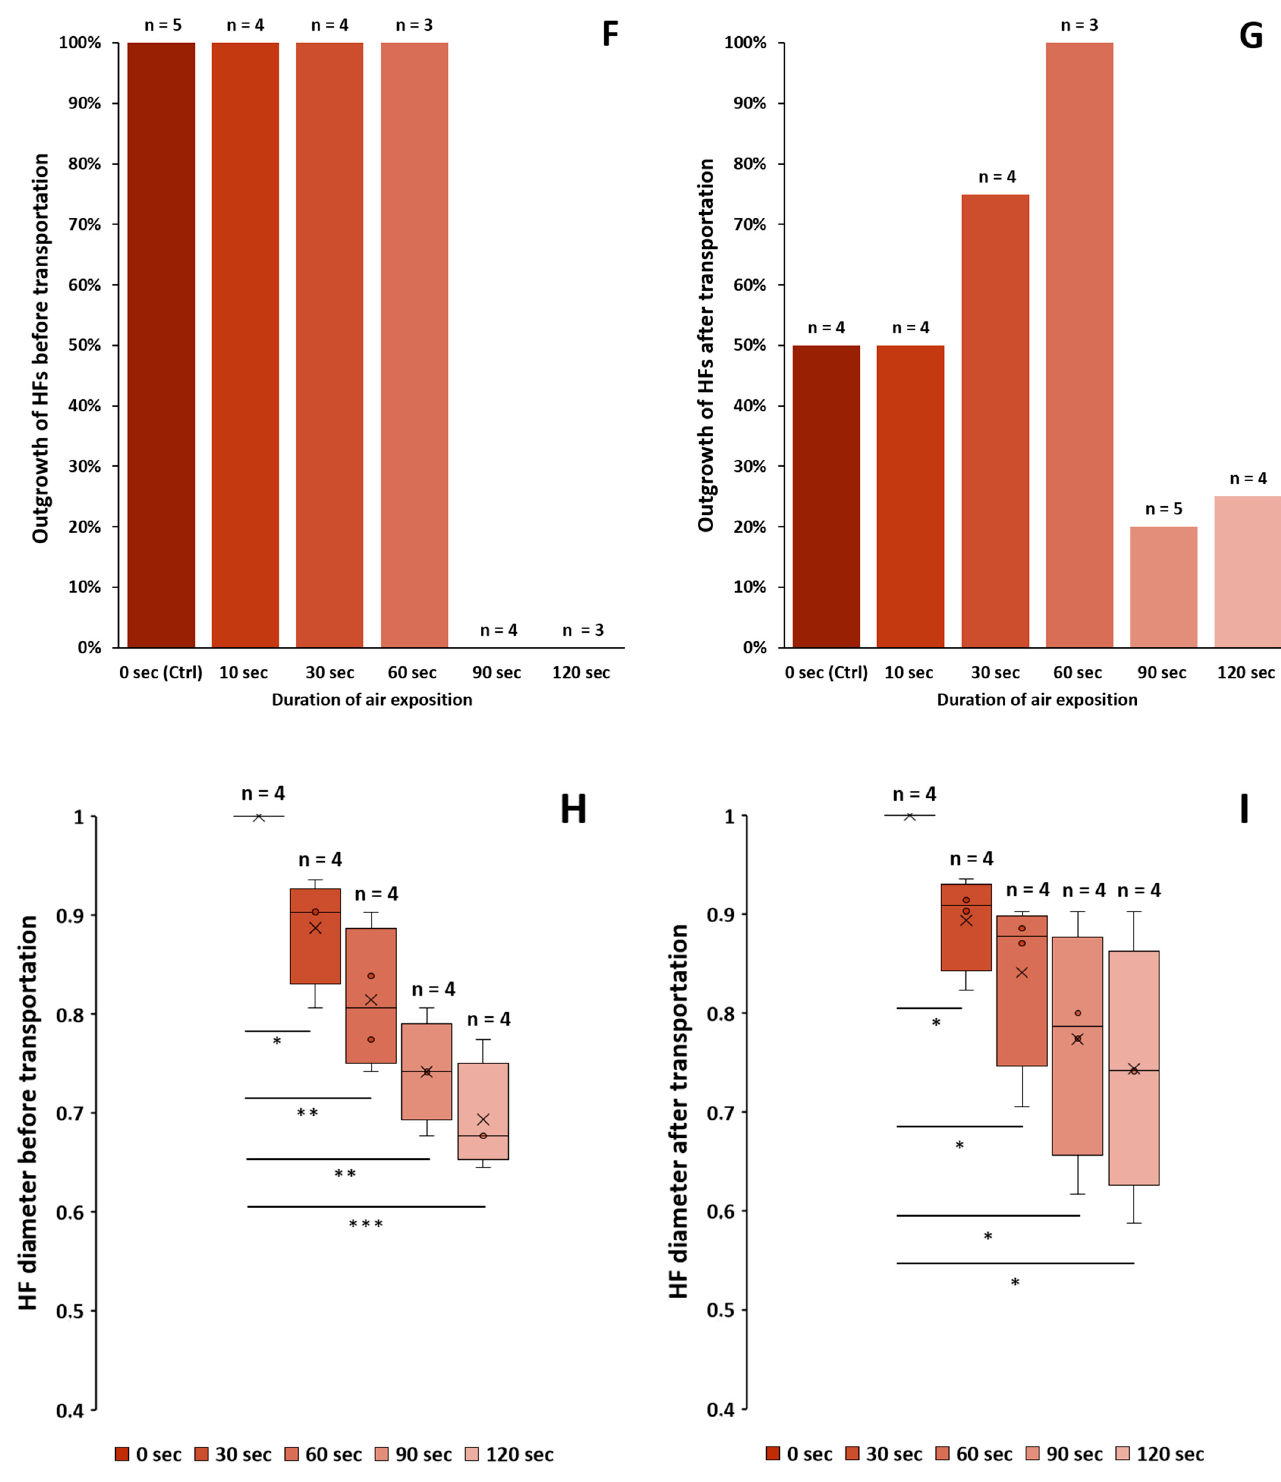
Figure 1. Anatomical structure and influence of ambient air exposure to plucked human hair follicles. ( A ) H&E staining of a sectioned, plucked human hair follicle. Longitudinal section with higher magnification of the proximal suprabulbar portion identifies the different layers shown in ( A ″ ) (black box). ( A ′ ), Distal cross-section of a human hair follicle (HF) displayed by a black line depicted in A. Outer root sheath (ORS) indicates the outermost layer with darker nuclear staining, followed by the inner root sheath (IRS) and the hair shaft (HS). ( B ) DIC picture of intact plucked human HF with clearly visible ORS and fully keratinized HS. ( C ) DIC picture of HF exposed to ambient air for 120